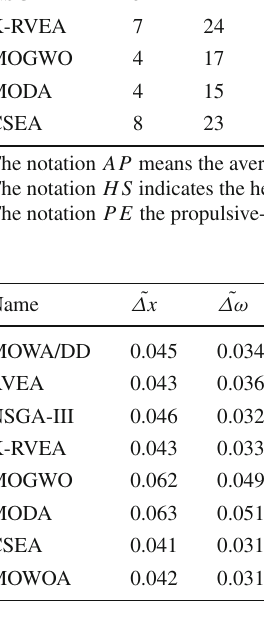
Table 7 The corresponding parameters and objective values of the final selected solutions obtained by each algorithm